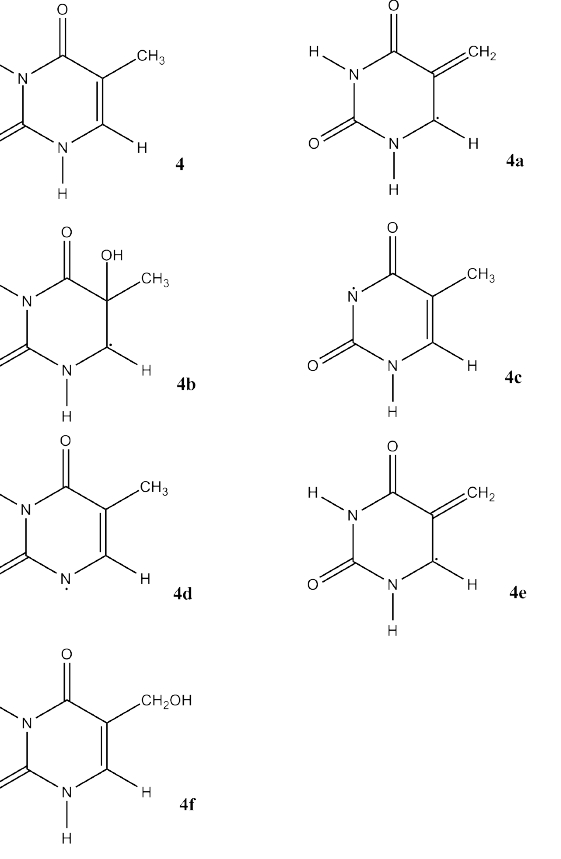
Figure 12. Reaction products of the electrolysis of thymine 4 . All these products were observed near the anode. 4c was observed near both